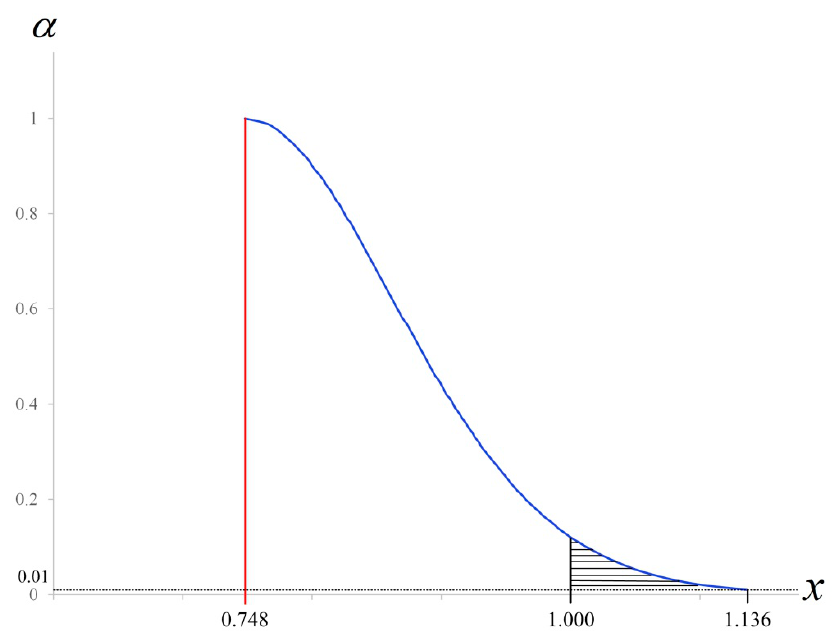
UC = , VL = 1.000 and 1.136 M